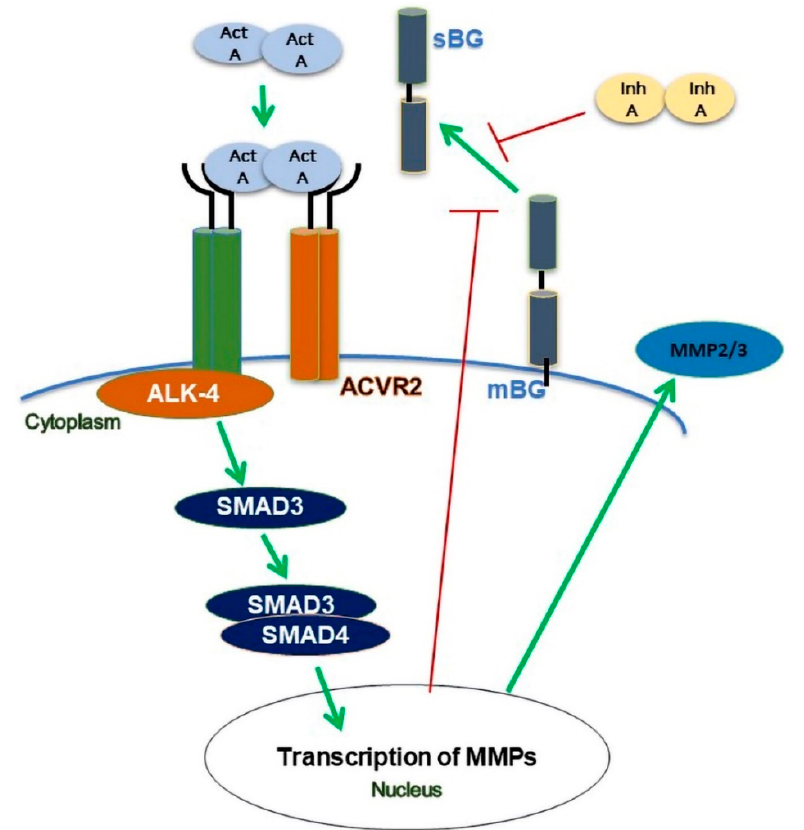
Figure 8. Scheme of modulation of betaglycan (BG) shedding in human endometrial cells. Binding of activin A (act A) to the ALK-4 receptor complex results in a reduction in BG shedding via phos- phorylation of SMAD3 but not of SMAD2. Activin A increases the secretion of MMP2 and MMP3. Inhibin A (inh A) decreases the shedding of BG and an activin A-mediated increase in MMP2 secre-